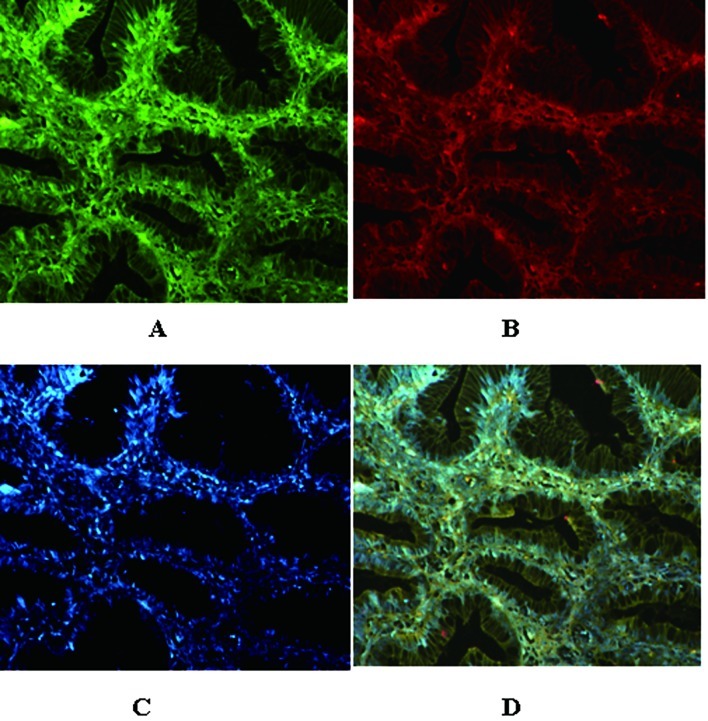
TGF-β1 and Lewis y colocalize in ovarian malignant tumors as detected by double-labeling immunofluorescence. (A) TGF-β1, (B) Lewis y, (C) nucleus and (D) merged image (original magnification, ×400).